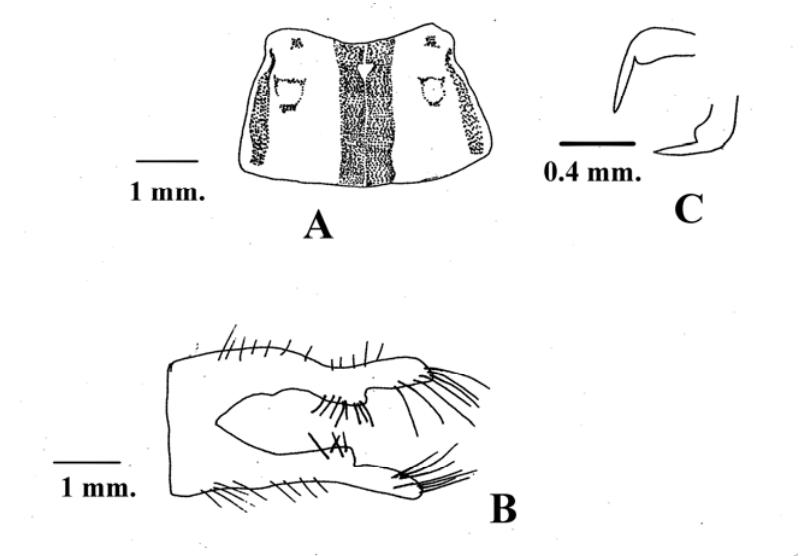
FIG . 1.- Accanthaclisis occitanica .A-pronotum , B-Epiproct , C- tibial